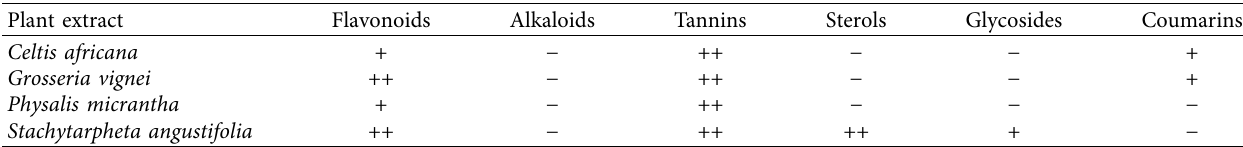
Table 3: Phytochemical composition of selected plants.